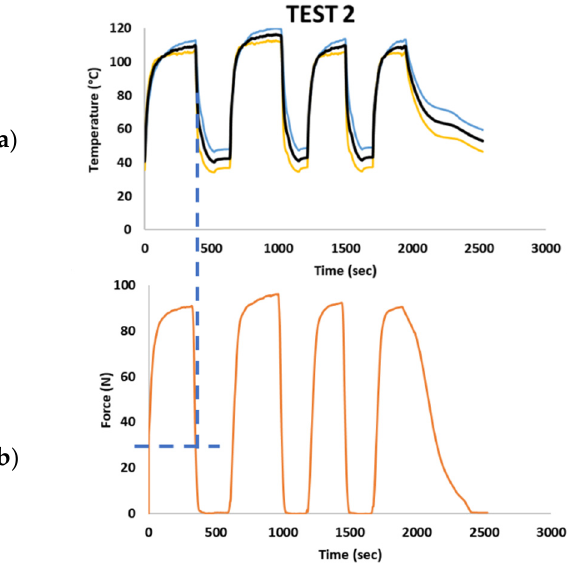
Figure 20. Experimental test results with a heat peak achieved of 110 °C: ( a ) temperature–time; ( b ) force–time.